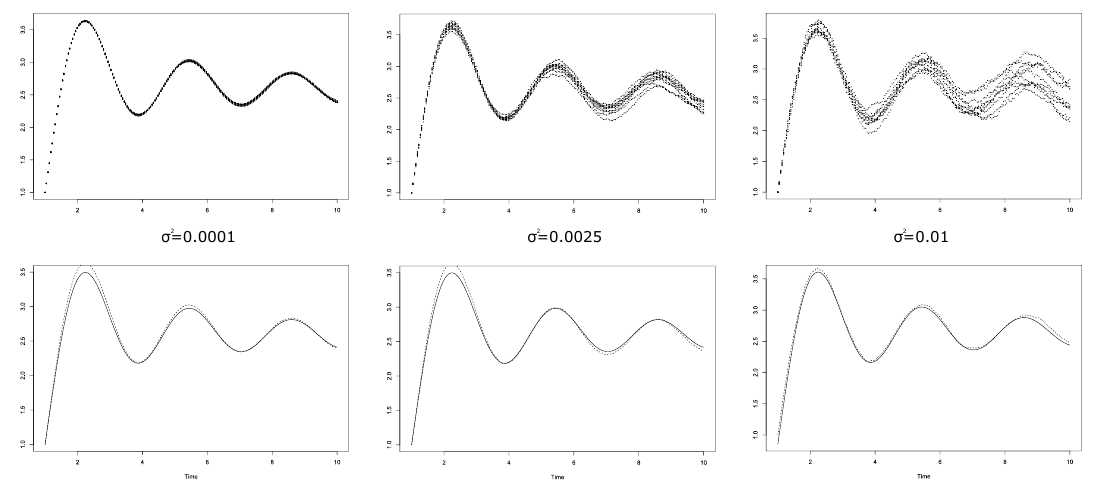
Figure 5. Sample paths (top) and simulated vs. estimated mean functions (bottom) for σ 2 = 0.0001, 0.0025, 0.01, (see Table